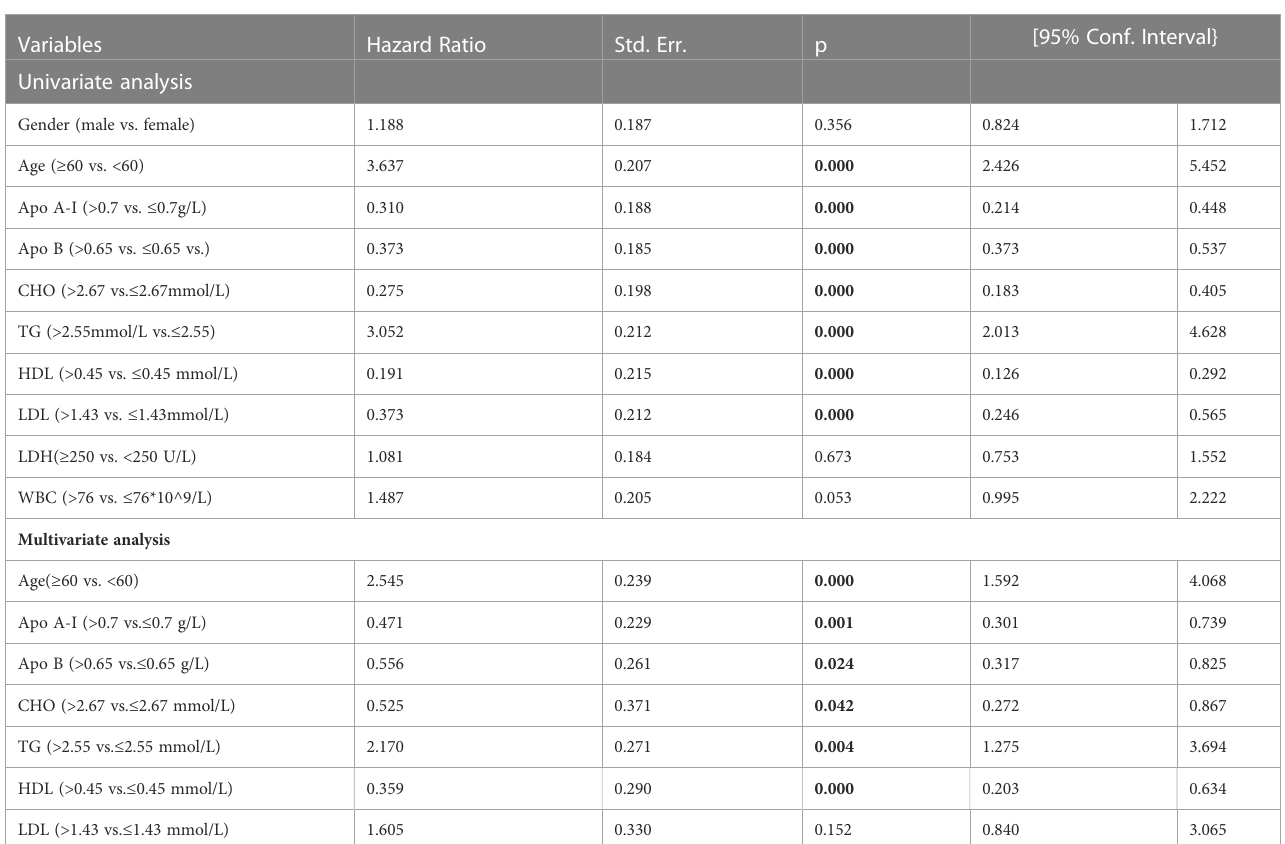
TABLE 1 Univariate and multivariate COX analysis of OS in AML patients. Variables Hazard Ratio Std.